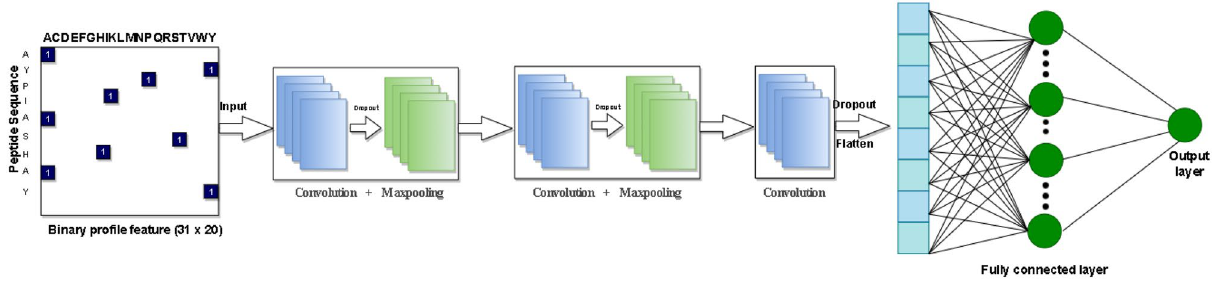
Figure 3. Model architecture of